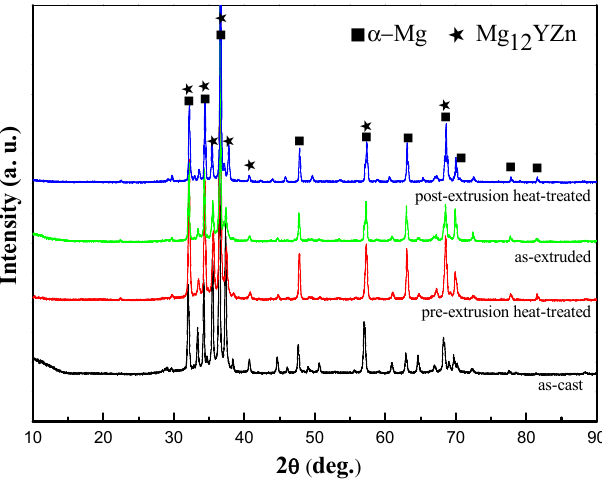
shape. After heat treatment at 540 °C for 5 h followed by extrusion, a large number of relative regular, homogeneous rod LPSO phases are formed with a small amount of white dots (Figure 2d).